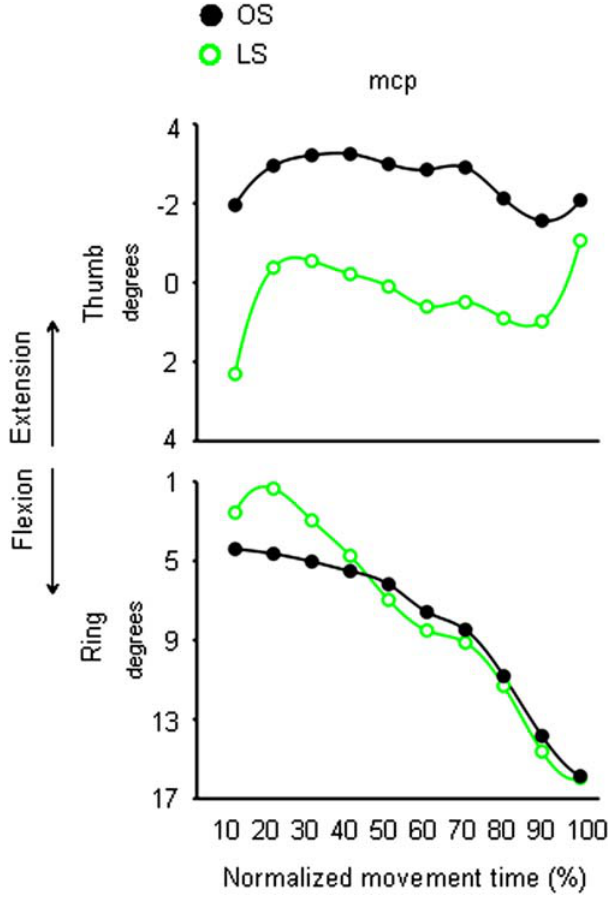
Figure 9. Time course of finger motion during reaching for the small target either in the absence or in the presence of an odour evoking a large object. Each trace depicts average angular excursion of a representative subject (Subject 2) for the mcp joint of the thumb and the ring finger when performing the ‘OS’ (black circles) and the ‘LS’ (green circles) conditions. Positive values correspond to finger flexion whereas negative values correspond to finger extension. OS=Odourless air-Small target; LS=‘Large’ odour-Small target.